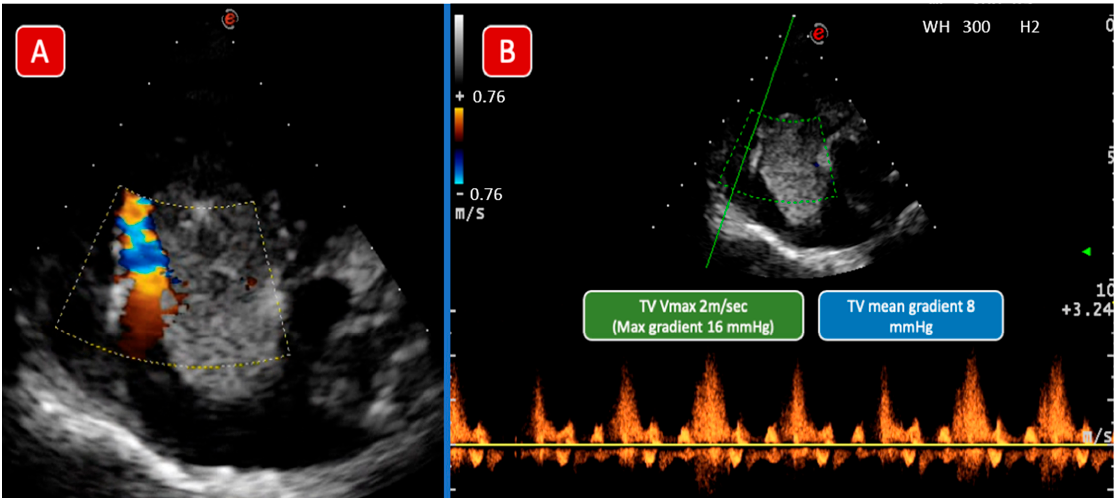
Figure 2. Case 1 echocardiographic images. Color Doppler image (Panel ( A )) shows a significant acceleration of diastolic flow at the level of the TV plane, almost entirely occupied by the mass. Panel ( B ) shows the CW Doppler trace which confirmed a severe TV stenosis. Abbreviations: TV: Tricuspid Valve; CW: Continuous wave.